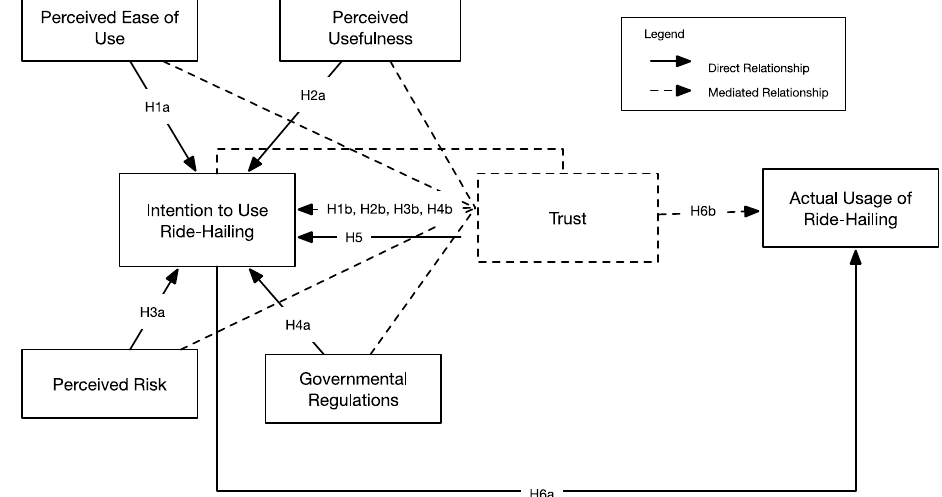
Figure 1. Our research model of extended